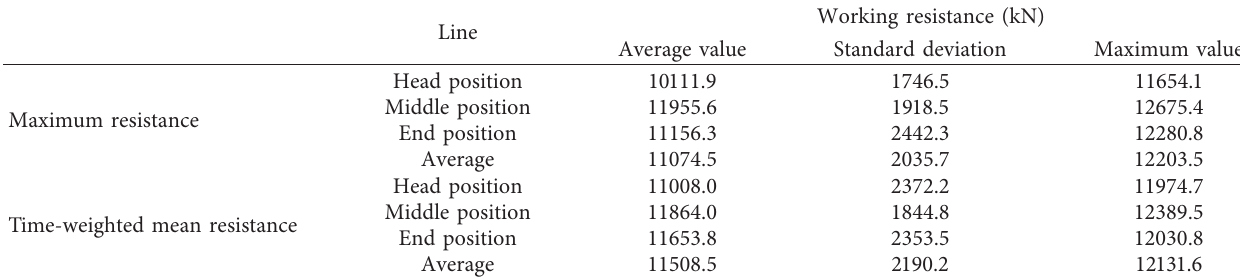
Table 2: Characteristics of the working resistance of working face